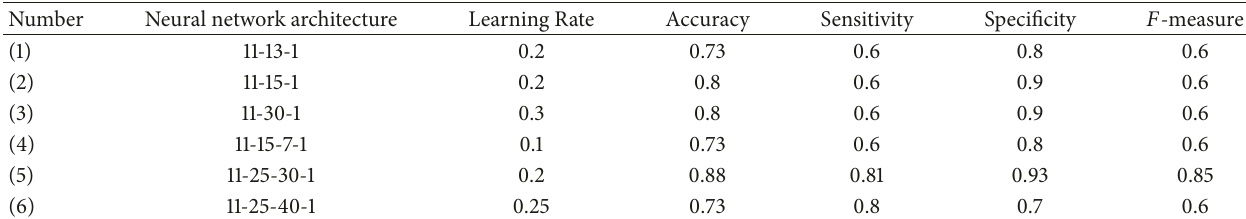
Table 3: Classifier performance for different neural network architectures.